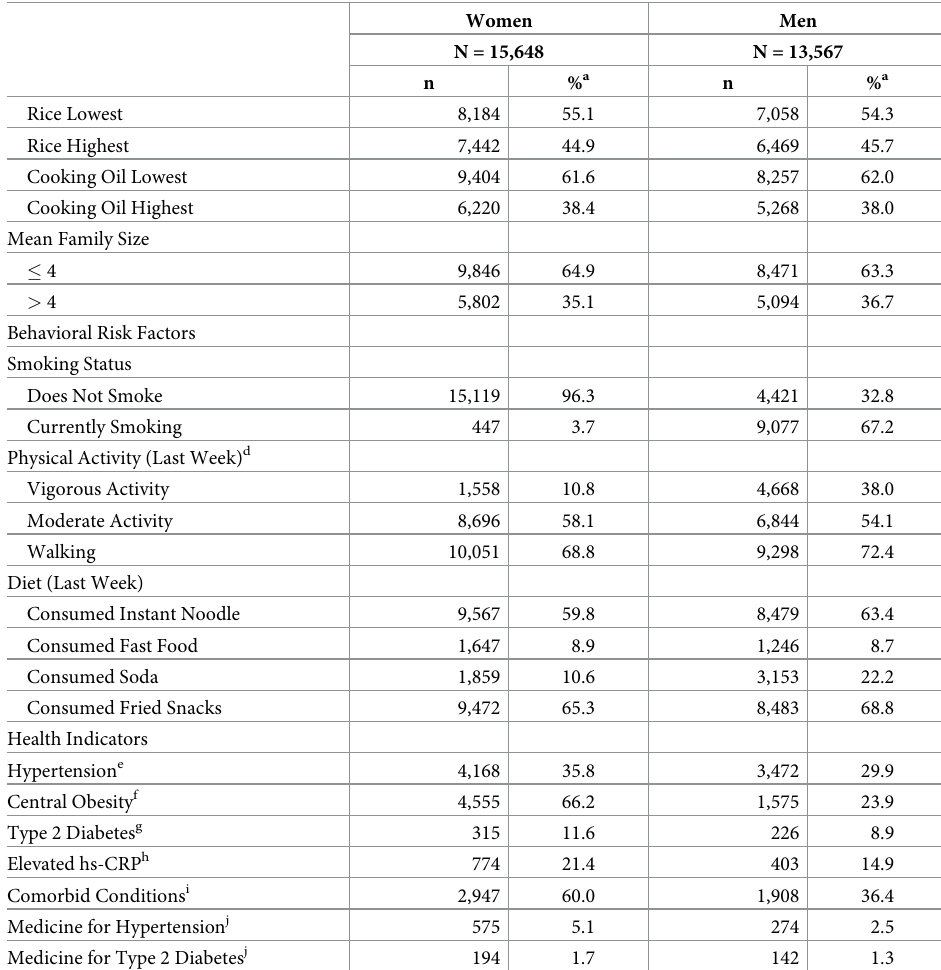
hs-CRP = high sensitivity c-reactive protein